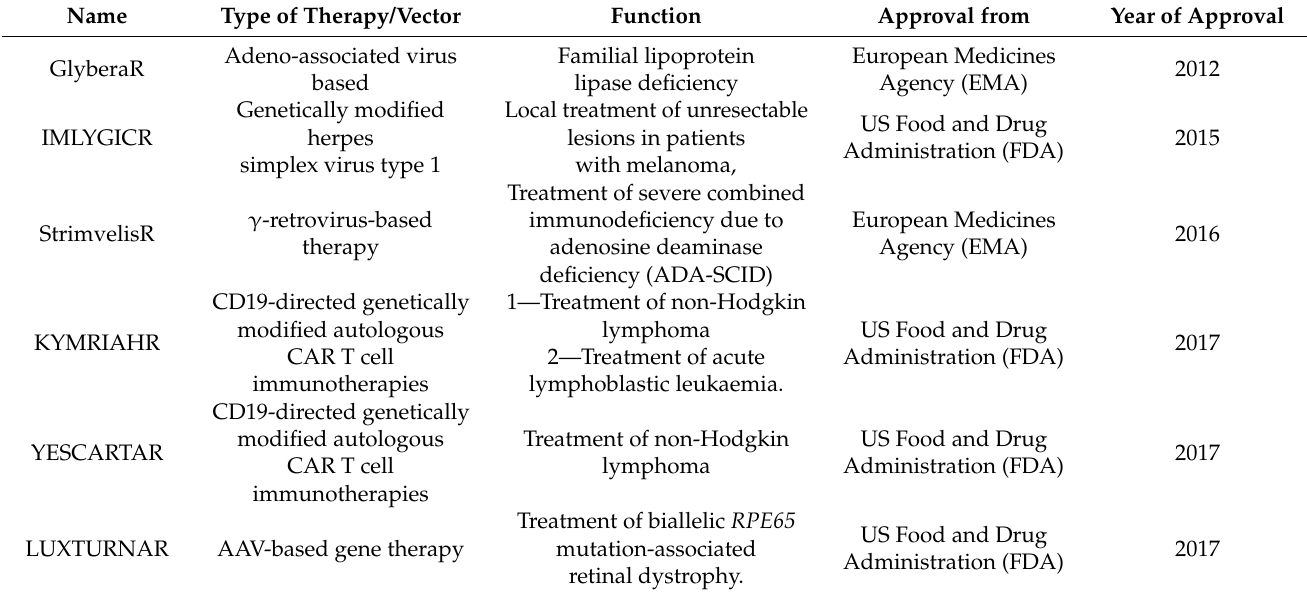
Table 2. Summary of the latest approved viral gene therapy